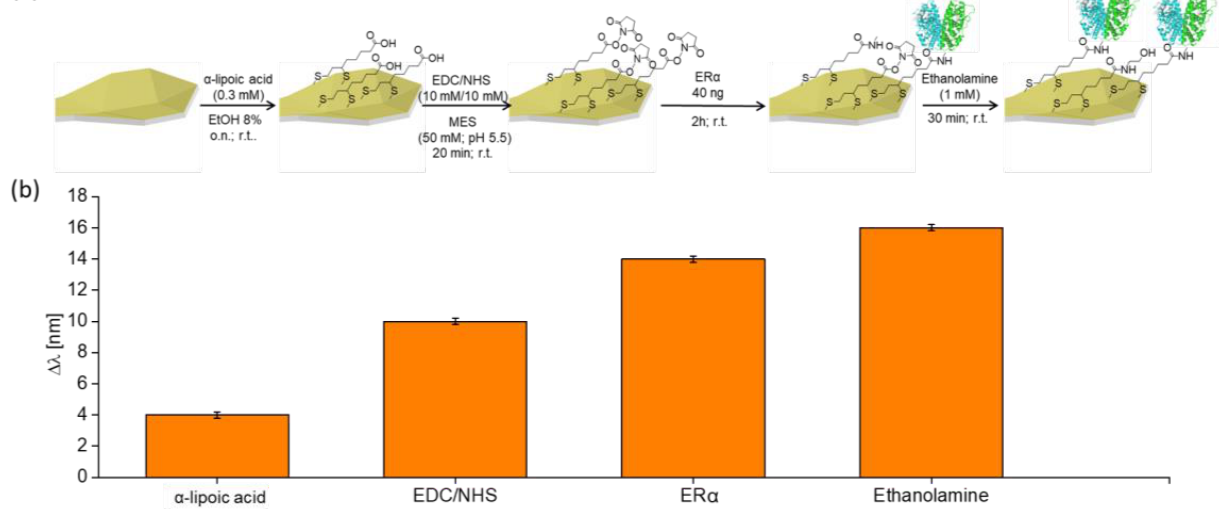
Figure 3. ERα functionalization: ( a ) scheme of functionalization procedure on SPR spoon-shaped probe; ( b ) variation in the resonance wavelength, calculated with respect to the bare chip considering PBS as surrounding medium, after each step of the functionalization process (n = 3, standard deviation (SD) = 0.15 nm).